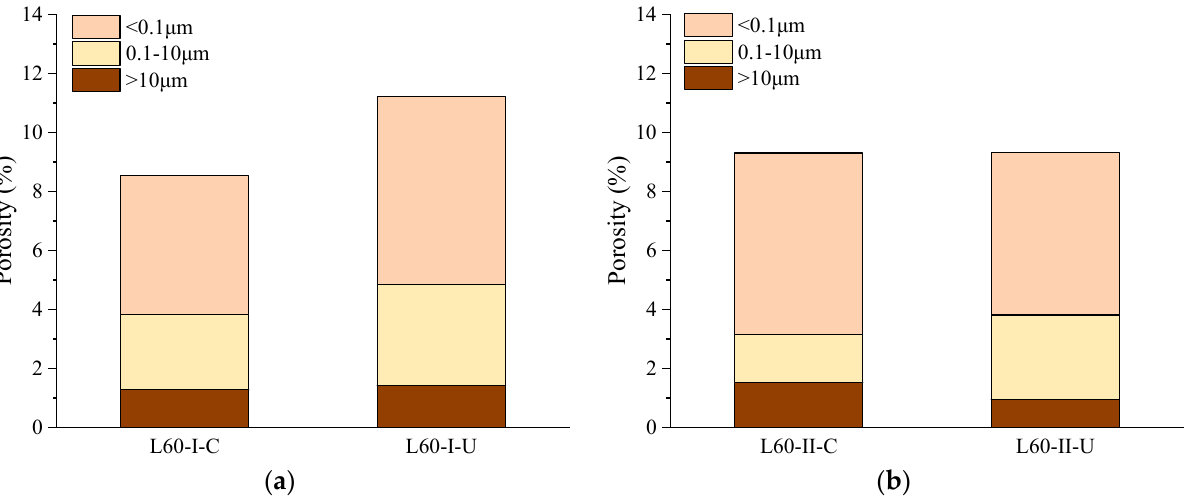
Figure 10. Comparison of the pore size distribution of samples at different depths and load levels: ( a ) zone I; ( b ) zone II.